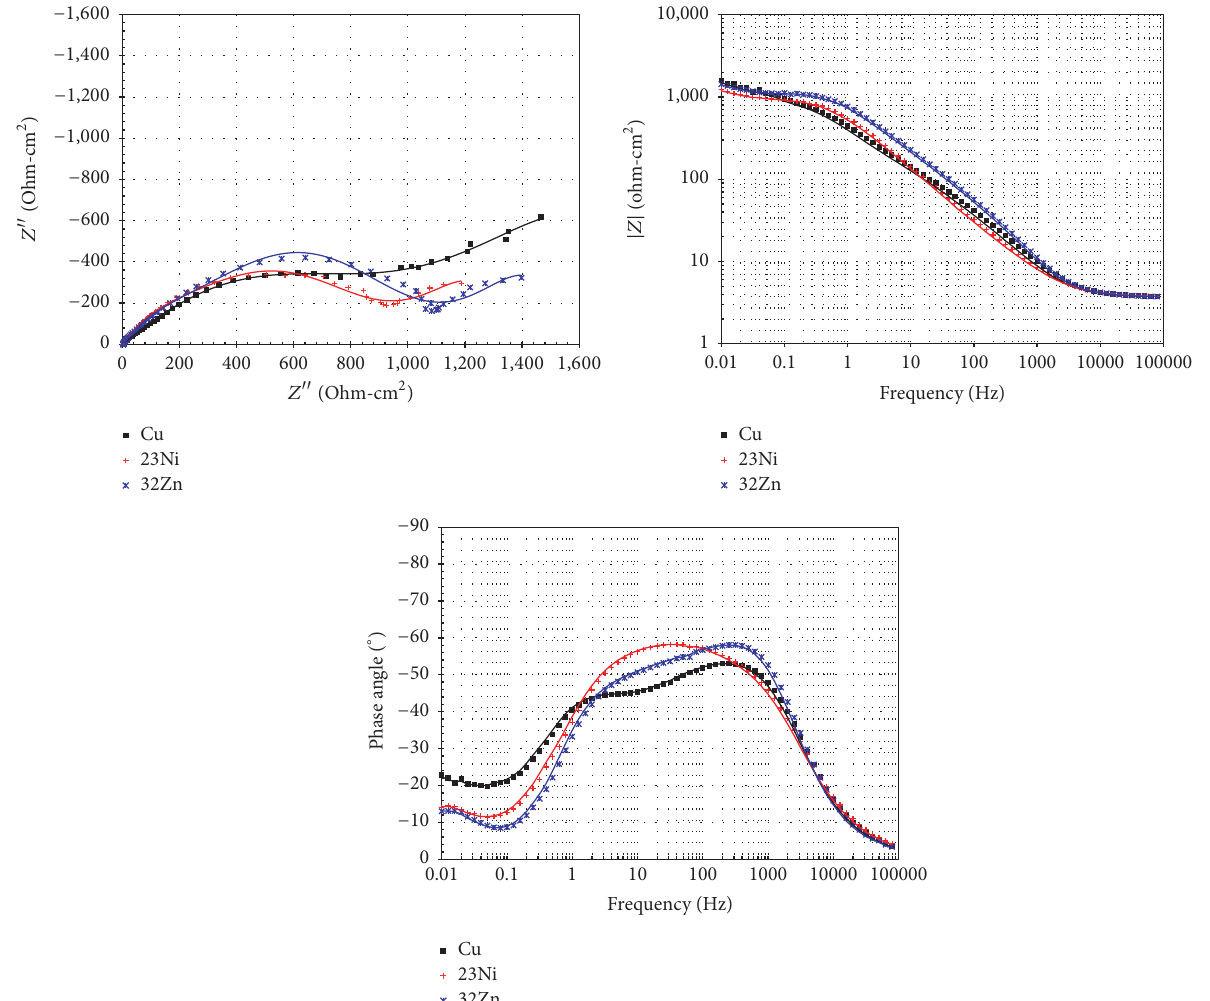
Figure 5: Nyquist and Bode plots for the Cu-based binary alloys in artificial sweat at 37 ∘ C after 24 hours. Points are the experimental data, and the continuous lines are the fitting